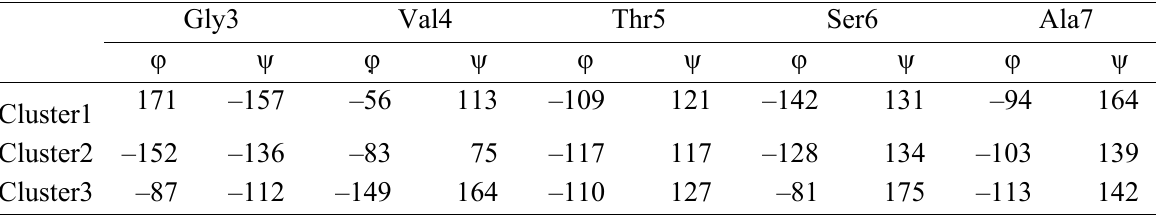
Table 1. Values of the torsion angles φ and ψ (in degrees) of amino acid residues in the average structure of each cluster for the peptide segment